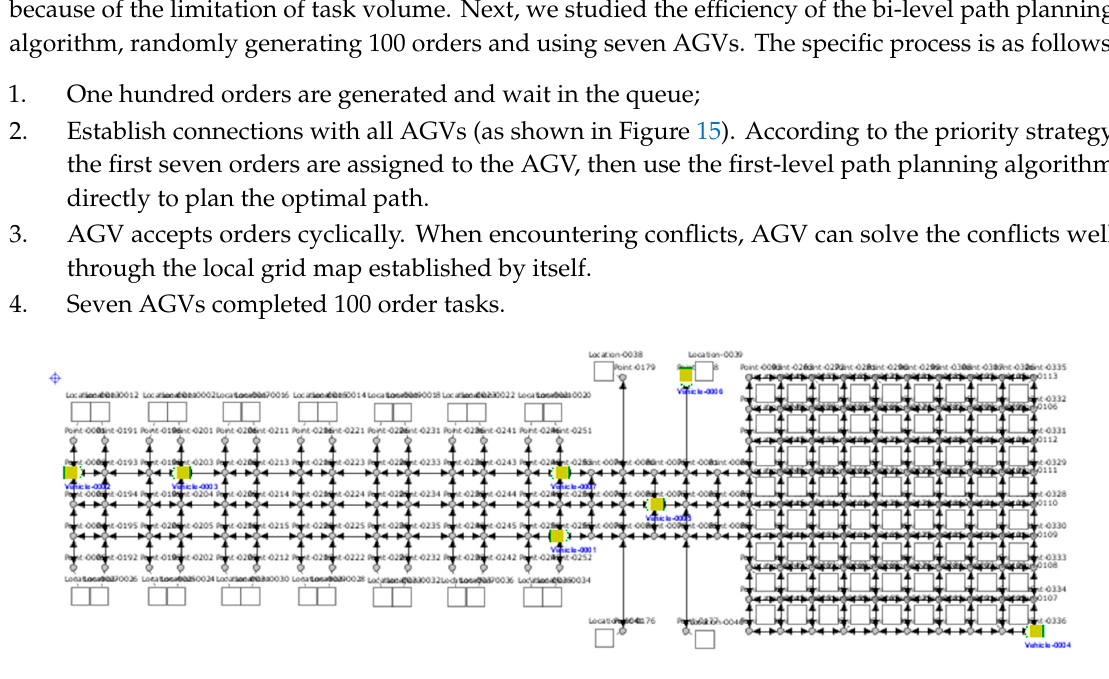
Figure 14. Task success.